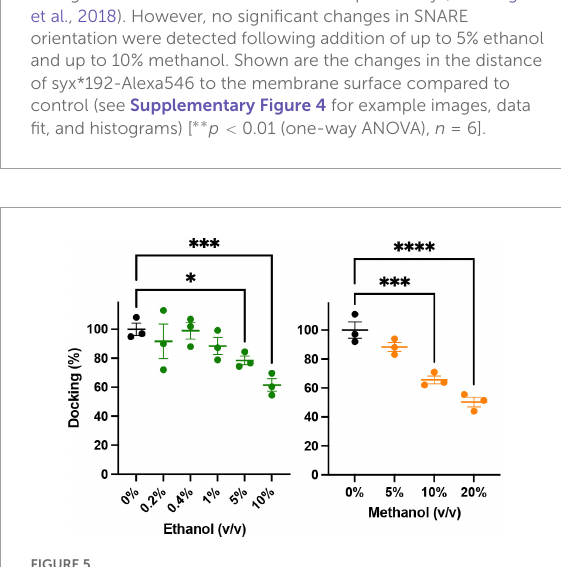
FIGURE5 Low concentrations of alcohols do not alter vesicle docking. Using TIRF microscopy, docking of reconstituted vesicles was measured and found to not significantly be affected by methanol or ethanol until ≥ 5% v/v was added. Error bars are 95% confidence intervals, ∗ , ∗∗∗ , and ∗∗∗∗ indicates p ≤ 0.05, p ≤ 0.001, and p ≤ 0.0001 respectively compared to controls (one-way ANOVA, n = 3) Supplementary Figure 5 shows example binding data with the fitted exponential first order kinetic